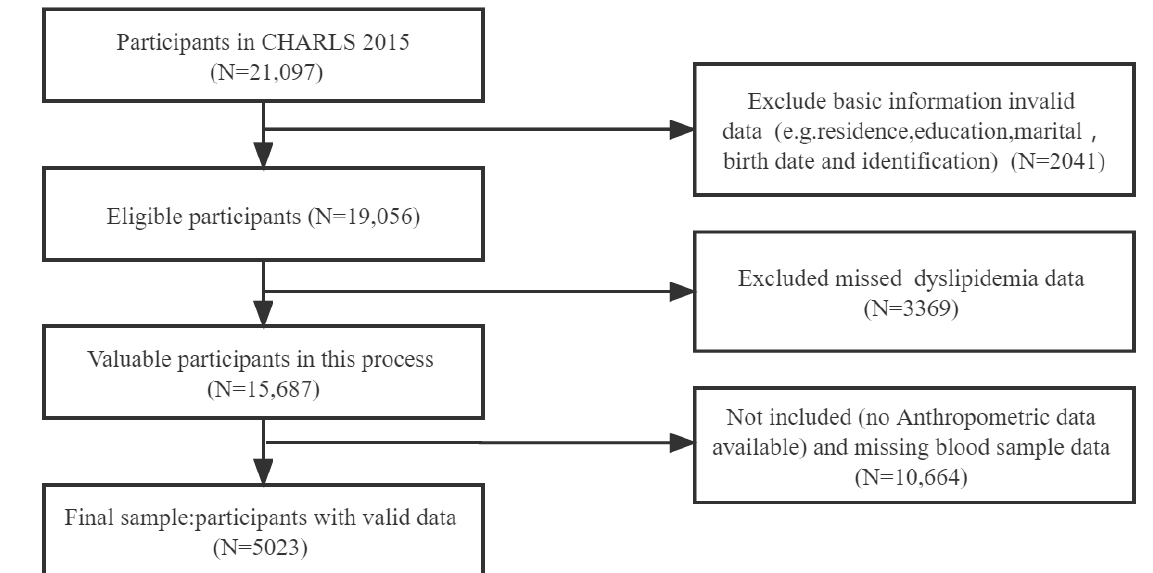
Figure 1. Flow diagram of the population in the project.